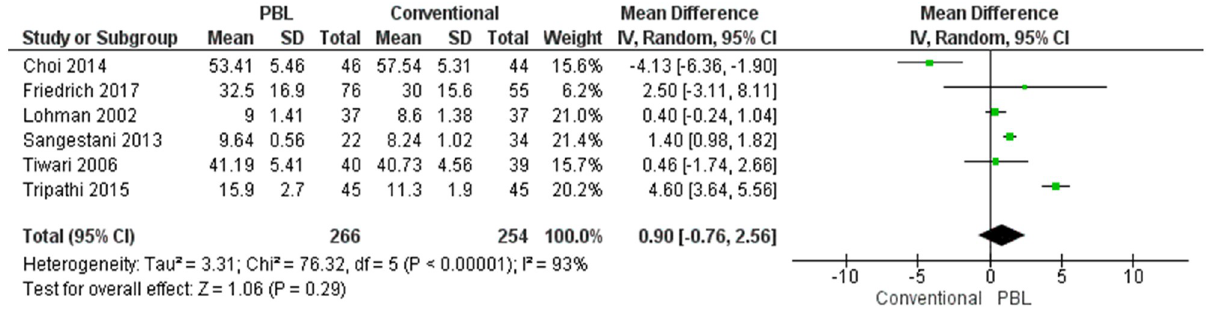
Fig 2. The analysis of the critical thinking/knowledge